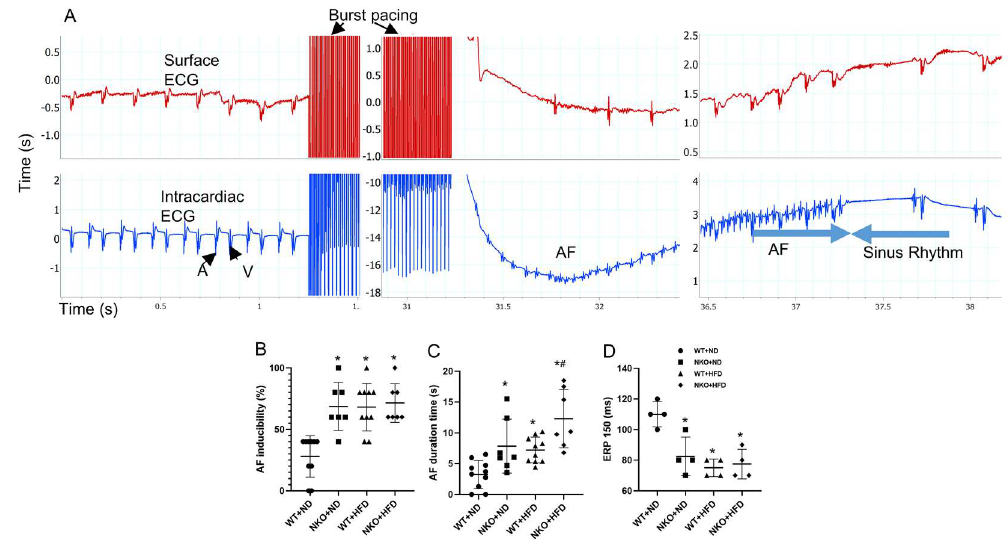
Figure 3. Electrophysiological study. ( A ) Typical mouse surface electrocardiogram (top) and endocardial electrogram (ECG; bottom) recordings during induced AF. A: intra-atrial ECG; V: intra- ventricular ECG. ( B ) scatter chart of AF inducibility. AF inducibility defined as the percentage of AF occurrence in 5 times pacing. ( C ) scatter chart of AF duration time. AF duration defined as the average AF duration time when AF happened. ( D ) AERP at the basic cycle length of 150 ms. * p < 0.05 vs. WT + ND mice; # p < 0.05 vs. WT + HFD mice ( n = 10 in WT + ND group, n = 7 in NKO + ND group, n = 10 in WT +